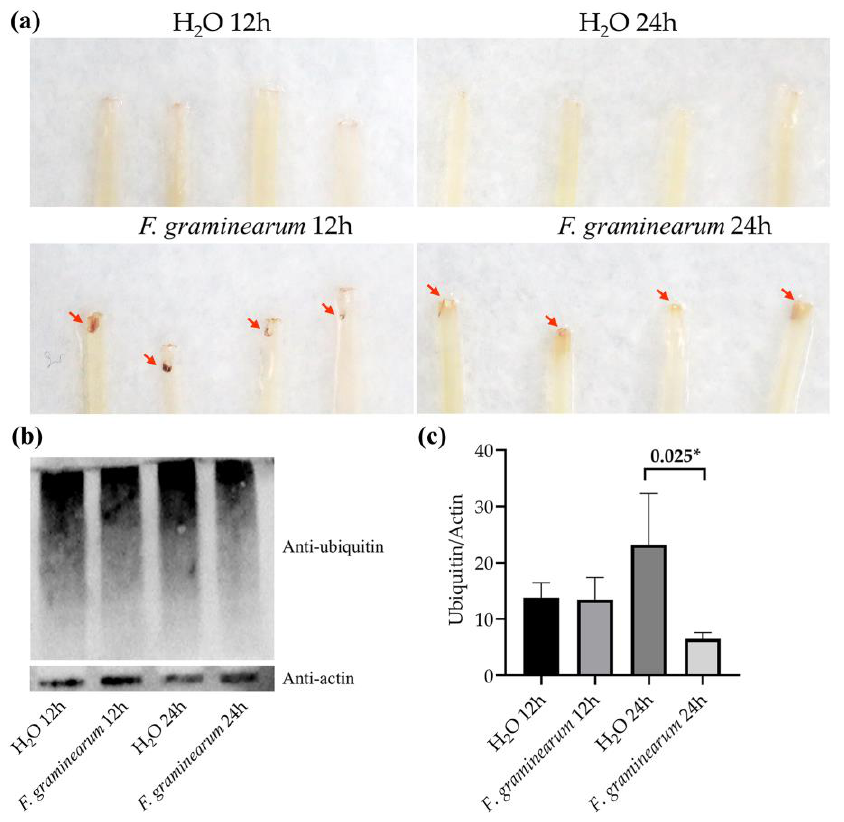
Figure 6. Detection of H 2 O 2 accumulation and protein ubiquitination of wheat coleoptiles at different stages after inoculation with F. graminearum . ( a ) 3,3-Diaminobenzidine (DAB) staining for H 2 O 2 accumulation. ( b ) Western blotting for protein ubiquitination level. H 2 O 12 h, samples 12 h-inoculated with distilled water; H 2 O 24 h, samples 24 h-inoculated with distilled water; F. graminearum 12 h, samples 12 h-inoculated with F. graminearum ; F. graminearum 24 h, samples 24 h-inoculated with F. graminearum . ( c ) Gray value analysis of Western blotting results. * p < 0.05.